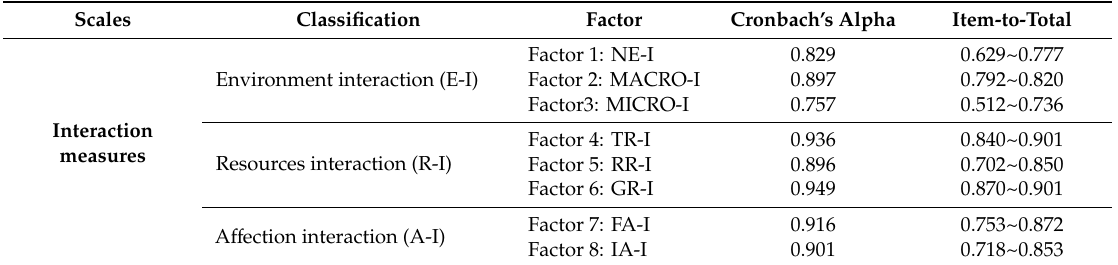
Table A2. Reliability and validity analysis result of each variable of initial